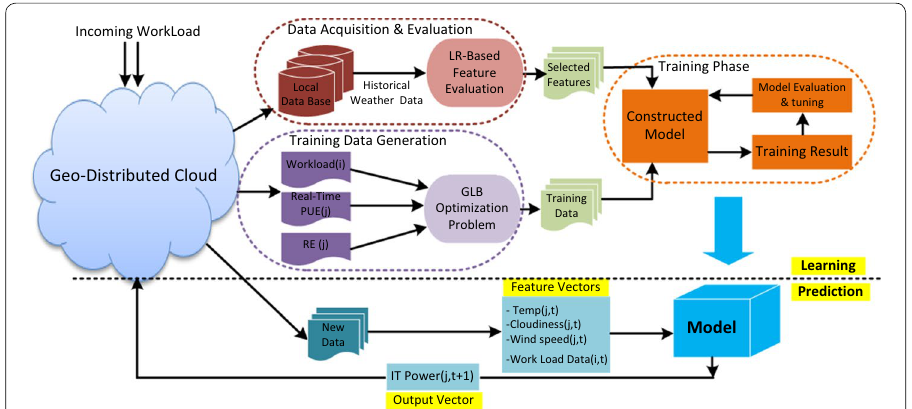
Fig. 4 Overall structure of the proposed